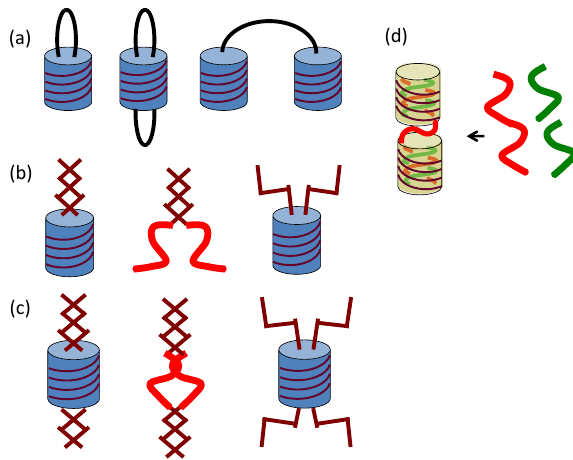
Figure 7. Linked cylindrical molecular complexes by covalent bond ( a ); single noncovalent bond domain ( b ); two noncovalent bond domains ( c ) and 1:2 double-helix complexes, where the length of oligomers are different ( d ).